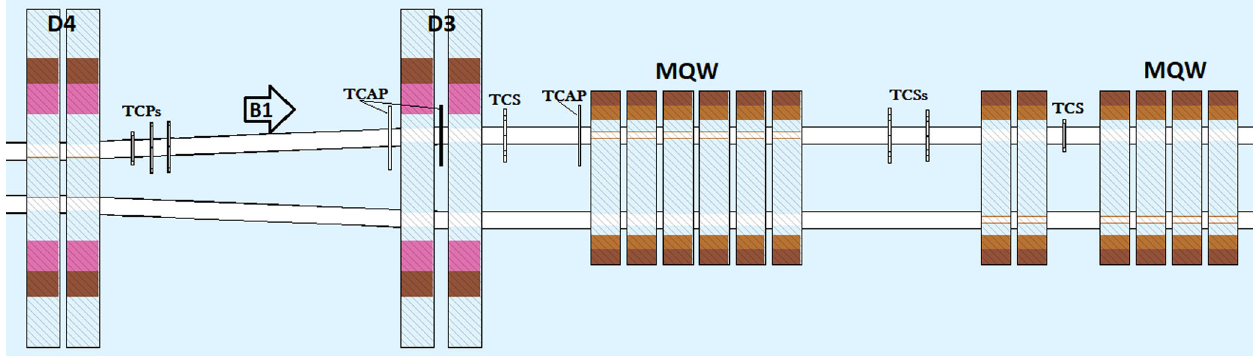
FIG. 13. Portion of the FLUKA model of the betatron collimation insertion, including warm dipoles (D3 and D4), collimators (TCP and TCS), warm quadrupoles (MQW), and passive absorbers (TCAP). The increase of the separation between the two beam pipes (from 204 to 224 mm, with reference to their axes) defines the so-called dogleg.